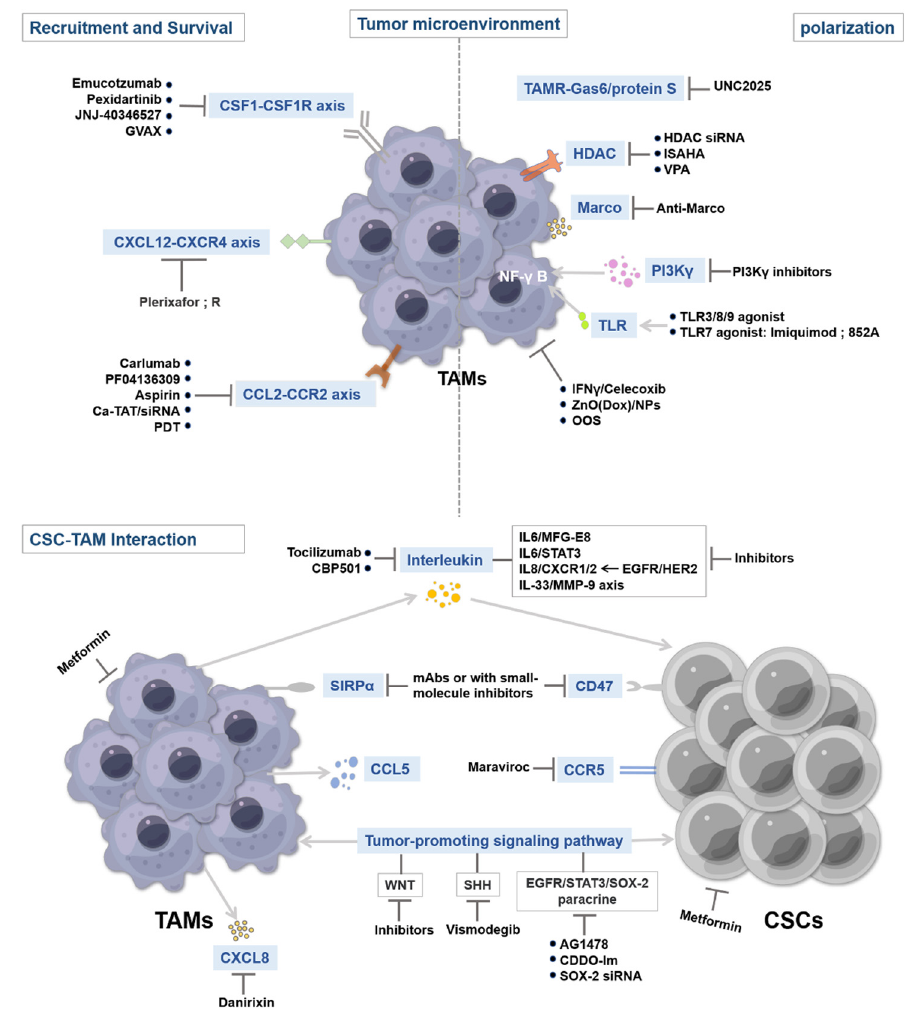
Figure 2. Targeting strategies of CSCs and TAMs in cancer therapy. Key pathways regulating CSC and TAM properties during tumorigenesis and progression have been identified, including TAM survival, recruitment, polarization, and phagocytosis and maintenance of CSC stemness. Targeting these pathways can help regulate CSC properties and TAMs and interfere with the interaction between them, thereby inhibiting the development of CSCs and providing more effective therapeutic strategies. Table 4. Drugs targeting the TAM-related pathways in clinical trials.